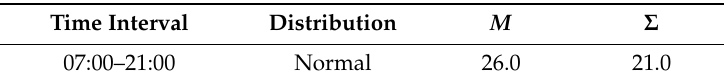
Table 1. Parameter of parking time pdf.